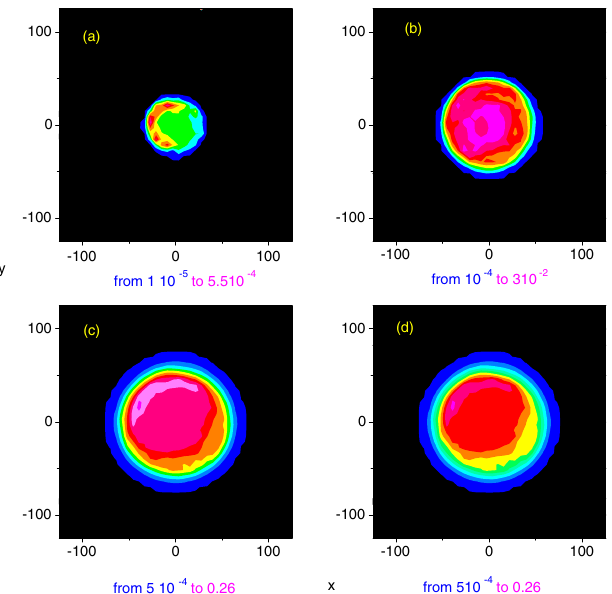
FIG. 2. (Color) Level curves of j A j 2 in the (cid:2) x; y (cid:3) plane for the same parameters of Fig. 1 and (a) t (cid:4) 15 ps , (b) t (cid:4) 45 ps , (c) t (cid:4) 75 ps , and (d) t (cid:4) 105 ps . Eqs. (17) and (18), where the very small parameter (cid:10) defined in Eq. (21) multiplies respectively the collective term in the transverse momentum equation and the diffrac- tion term in the wave equation. In a second stage, if the beam radius becomes larger than the laser spot radius the radiation tends to remain concentrated inside the interac- tion region. In Fig. 3 the spectrum of the signal is represented in the (cid:4) 0 : 6 (cid:11) m versus the quantity (cid:4) != (cid:2) !(cid:9) (cid:3) , so that case of " n this graph gives immediately the bandwidth in terms of (cid:9) .